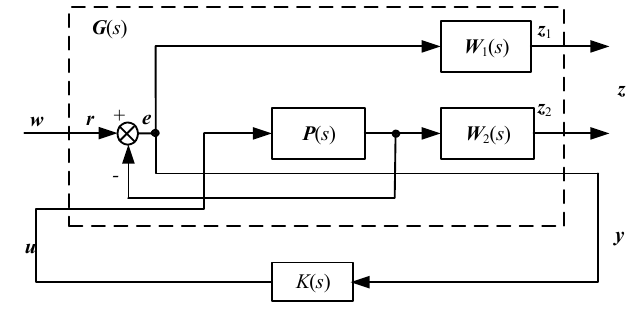
Figure 6. The mixed-sensitivity design methodology diagram being transformed to a H standard